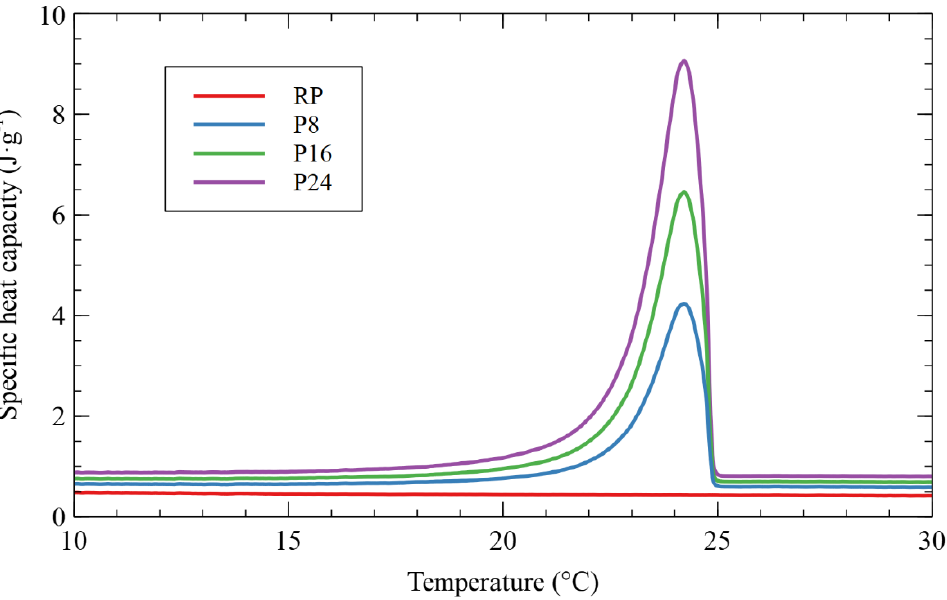
Figure 4. Temperature-dependent specific heat capacity of studied FSPCM plasters during heating.